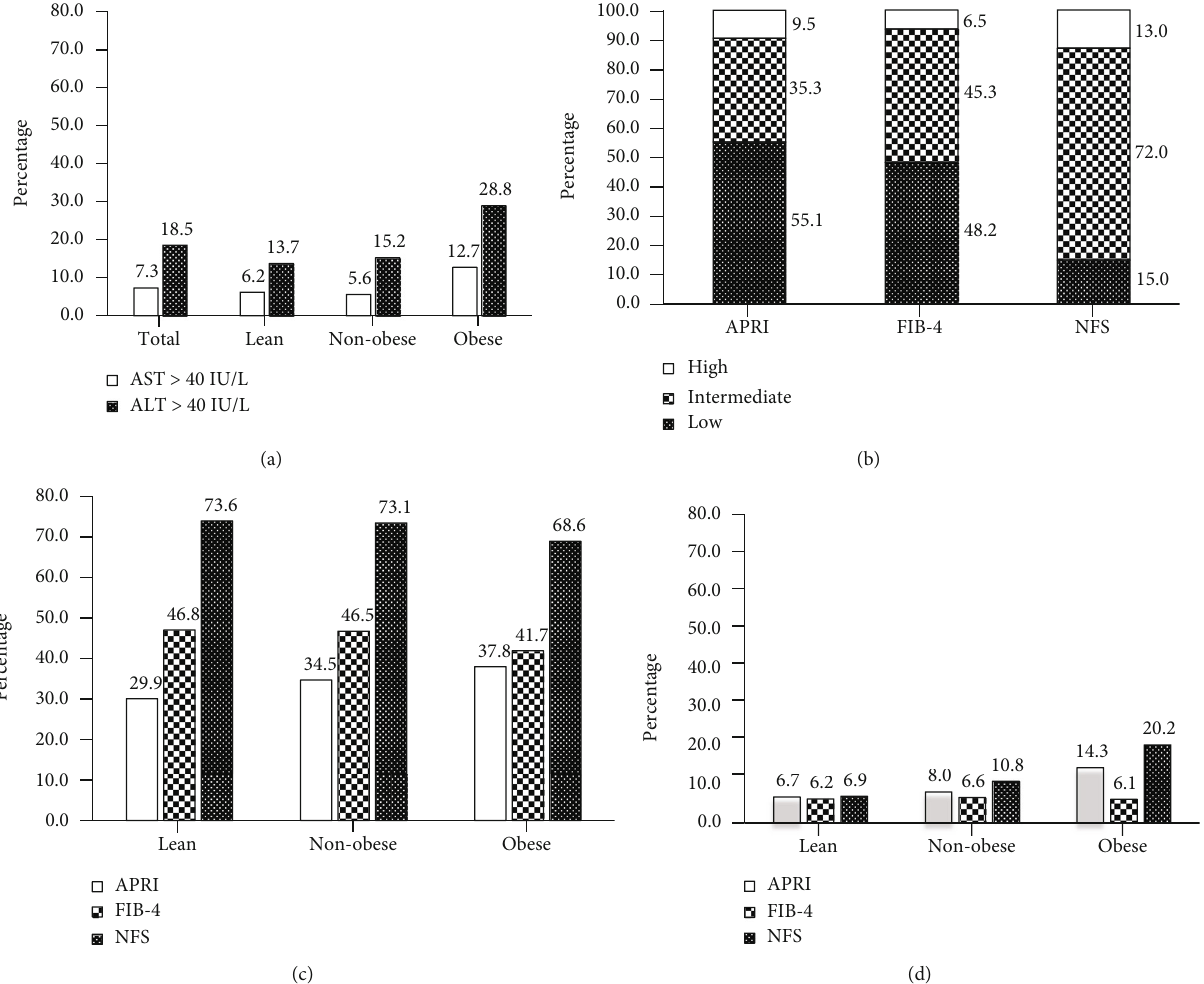
Figure 2: (a) Proportions of patients having plasma AST or ALT levels ≥ 40U/L in total MAFLD, lean, nonobese, and obese MAFLD. (b) Distributions of noninvasive liver fi brosis scores in MAFLD patients. (c) Proportions of patients having “ intermediate ” risk of fi brosis for each score in lean, nonobese, and obese MAFLD patients. (d) Proportions of patients having “ high ” risk of fi brosis for each score in lean, nonobese, and obese MAFLD patients. AST: aspartic acid aminotransferase; ALT: alanine aminotransferase; APRI: AST-to-platelet ratio index; FIB-4: fi brosis-4 index; NFS: nonalcoholic fatty liver disease fi brosis